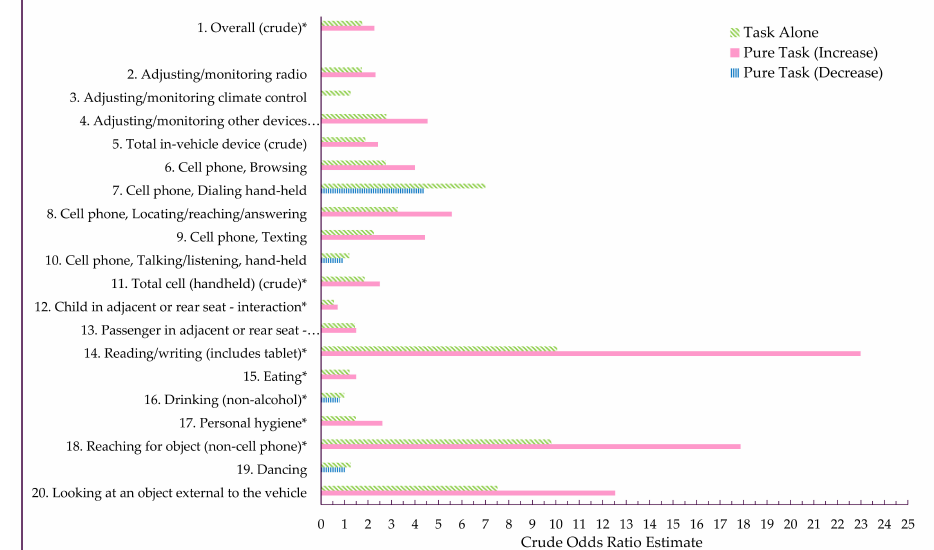
Figure A3. Task Alone compared to Pure Task. Diagonally-hatched green bars : “Task Alone” OR point estimates (same as hatched bars in Figure A2). Vertically-hatched blue bars : “Pure Tasks” with decreased OR point estimates after driver behavior errors removed. Solid red bars: “Pure Tasks” with increased OR point estimates after driver behavior errors removed. * indicates the category was formed from heterogeneous tasks that should not have been